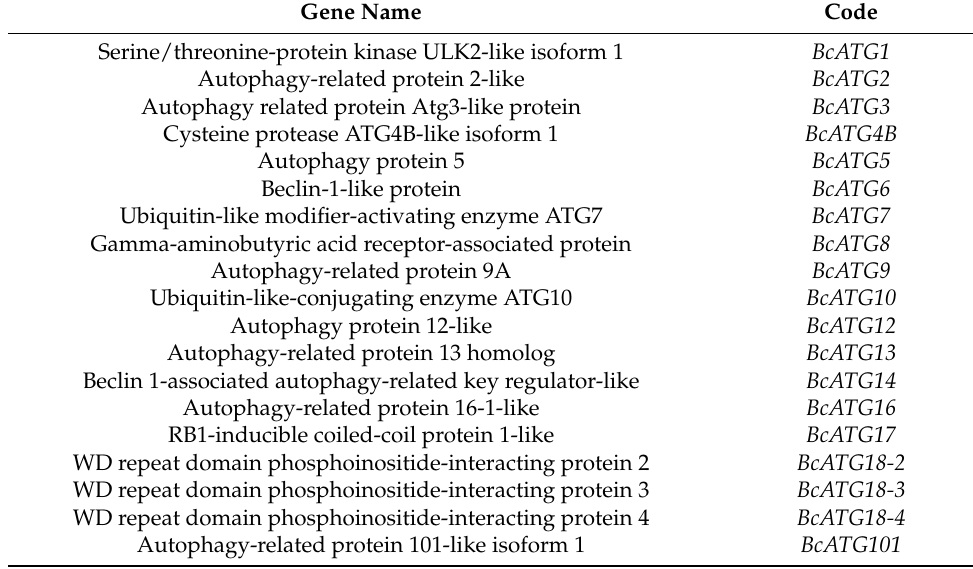
Table 1. Name of B. cockerelli autophagy-related genes and their codes used in this